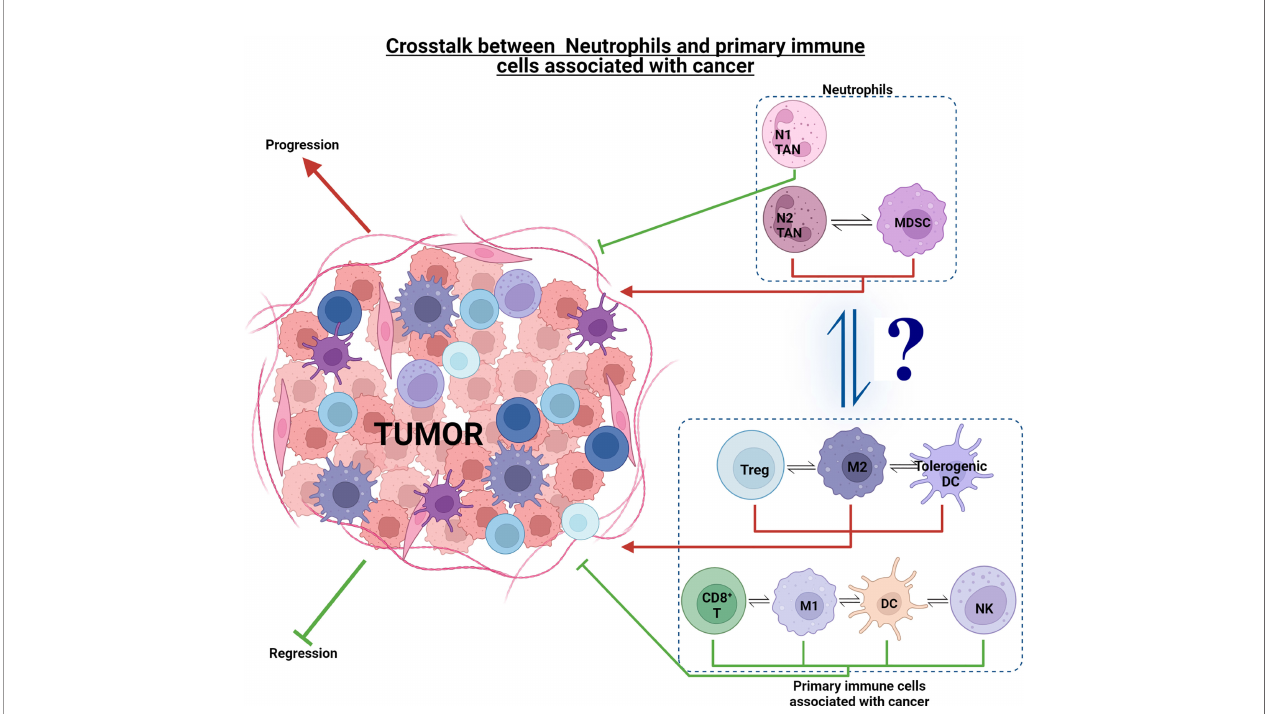
FIGURE 1 | Effect of neutrophils and other immune cell sub-phenotypes on tumorigenesis. Immune cells such as CD8 + T, M1 TAMs, DCs, NK, and N1 TANs exhibit an anti-tumor response and aid in tumor regression. On the other hand, tumorigenic cells such as Treg, M2 TAMs, tolerogenic DCs, N2 TANs, and MDSCs, exhibit pro-tumor response and aid in tumor progression. There is complex interplay within the anti- and pro-tumor cell groups, as well as interaction of neutrophils with these cell groups to drive tumorigenesis in the TME